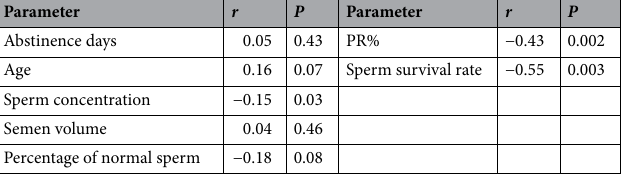
Table 2. Correlation analysis between sperm DFI and semen